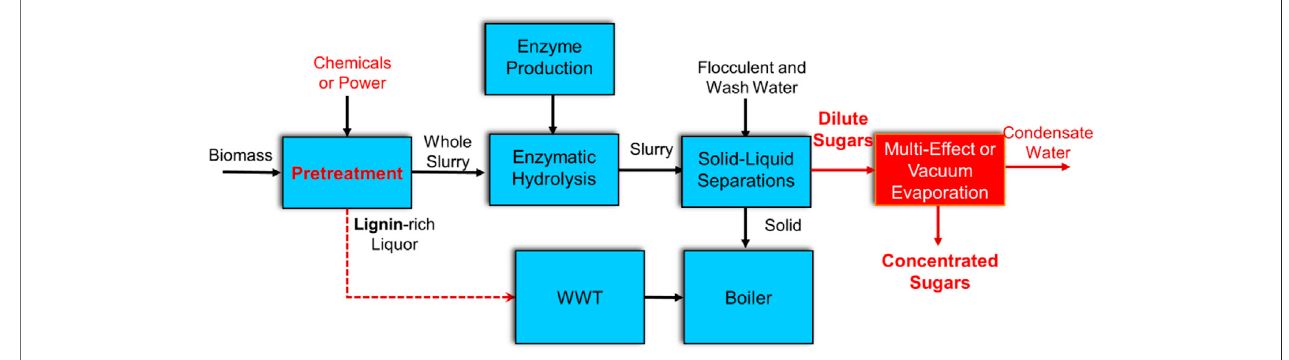
FIGURE 2 | Block diagram schematic of cellulosic sugars model process. Options for concentrating sugar or not are highlighted in